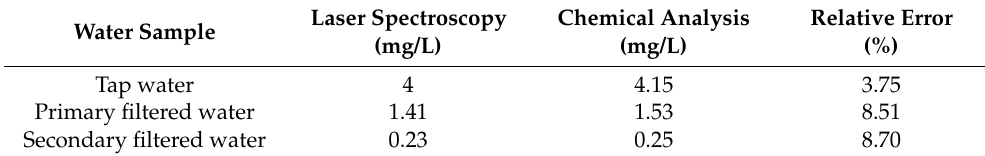
Table 4. The comparison of the permanganate index measurement.